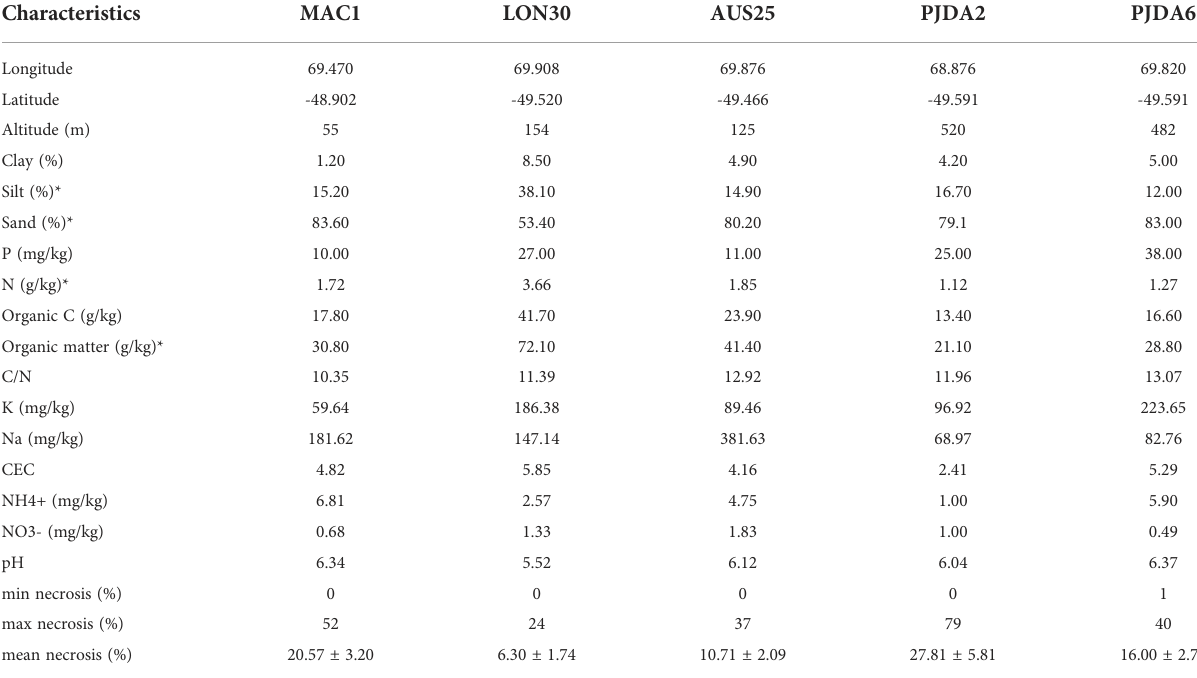
TABLE 1 GPS coordinates of the studied sites and their soil physico-chemical properties and plant necrosis parameters, “ * ” indicates the variables removed for the NMDS analysis due to correlation with other variables.